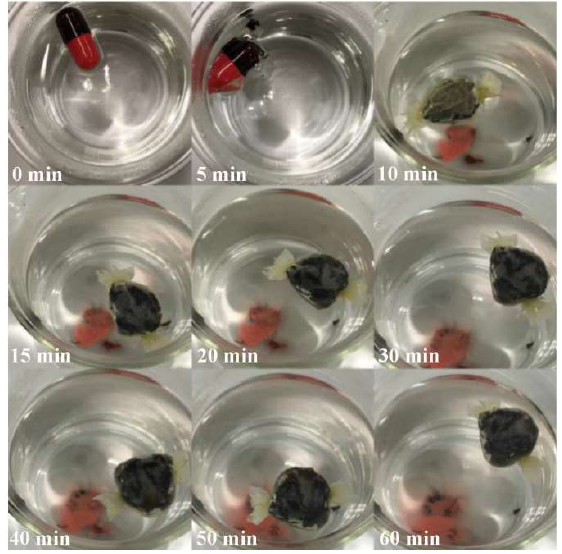
Figure 2. Black fungus inside the casing and the gelatin capsule after shaping in the 3D printed molds. The photos are from taken at 0, 5, 10, 15, 20, 30, 40, 50, and 60 min. The final expanded size was 2.5 cm in diameter.